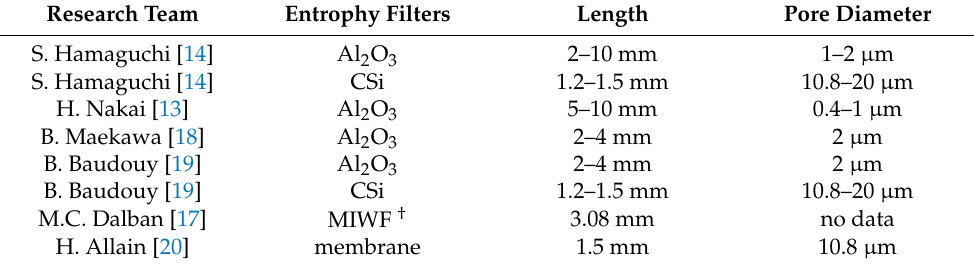
Table 1. Entrophy filters.